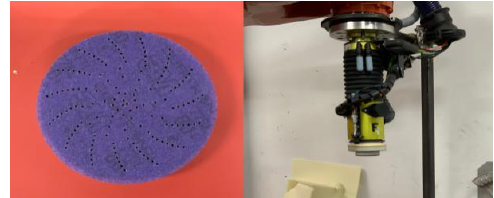
Figure 9. Main components of reconditioning cell during integration testing.